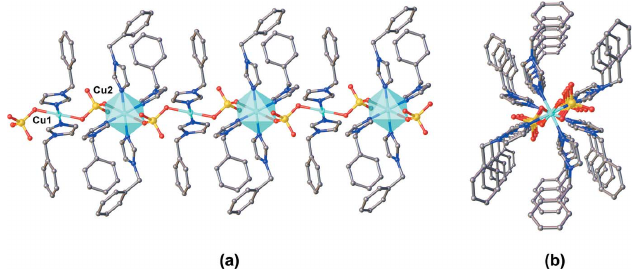
Figure 2 Side ( a ) and top ( b ) views of the chain-like structure of the title compound extending parallel to the c axis. Hydrogen atoms bound to carbon atoms as well as solvent water and DMF molecules were omitted for clarity.